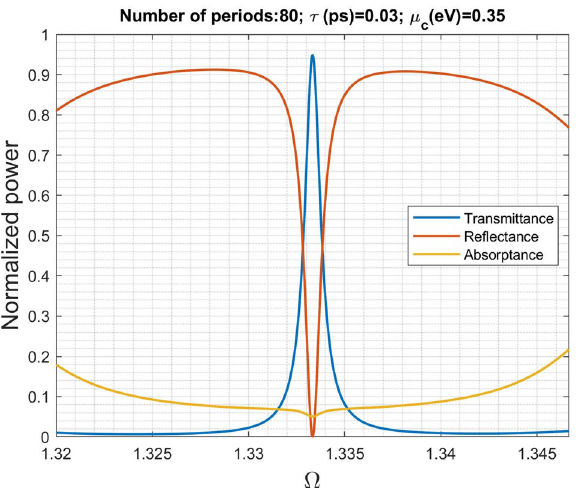
Figure 8. The scattering characteristics of the same 1D metamaterial but with the wave impedance equal to 11.922 (cid:31) in the input and output region; the original one is 251 (cid:31)